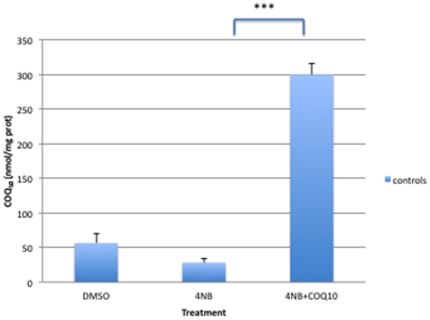
CoQ10 levels in control skin fibroblasts (n = 5) after treatment with DMSO, 4 mM 4-NB alone, or 4 mM 4-NB+5 µM CoQ10.The values are nmol/mg-protein (***P<0.001).